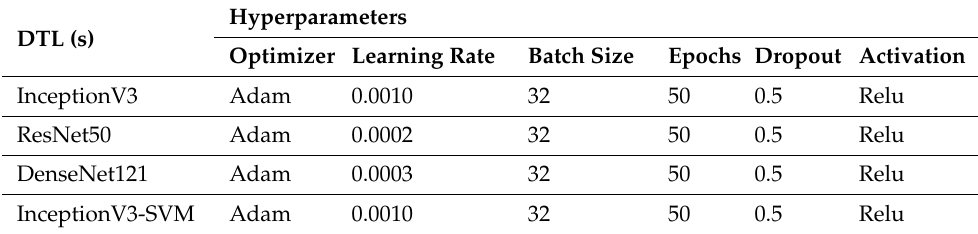
Table 2. Details of the hyperparameter